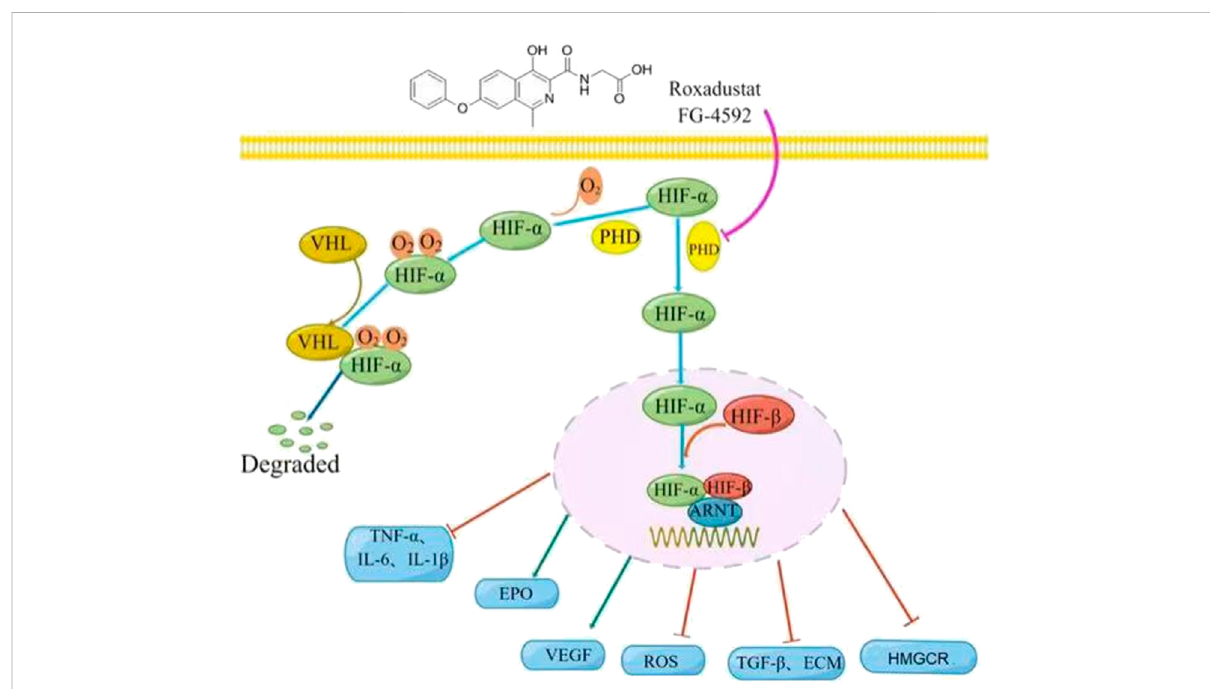
FIGURE 1 Roxadustat mechanism of action. Left: Under normoxic conditions, the prolyl hydroxylase domain (PHD) hydroxylates the oxygen-sensitive α subunit of hypoxia-inducible factor (HIF- α ), and the von Hippel-Lindau tumor suppressor (VHL) recognizes the hydroxylated HIF- α , which is then ubiquitinated and degraded by ubiquitin. Right: Roxadustat (or hypoxia) inhibits the activity of PHD, leading to the accumulation of HIF- α , which subsequently moves into the nucleus where it forms a transcriptional complex with HIF- β and aryl hydrocarbon receptor nuclear translocator (ARNT), and then binds to the hypoxia response element, thereby regulating the expression of many genes (TNF- α , IL - β , IL-6, EPO, VEGF, TGF- β , HMGCR, etc.), as well as the production of ROS and